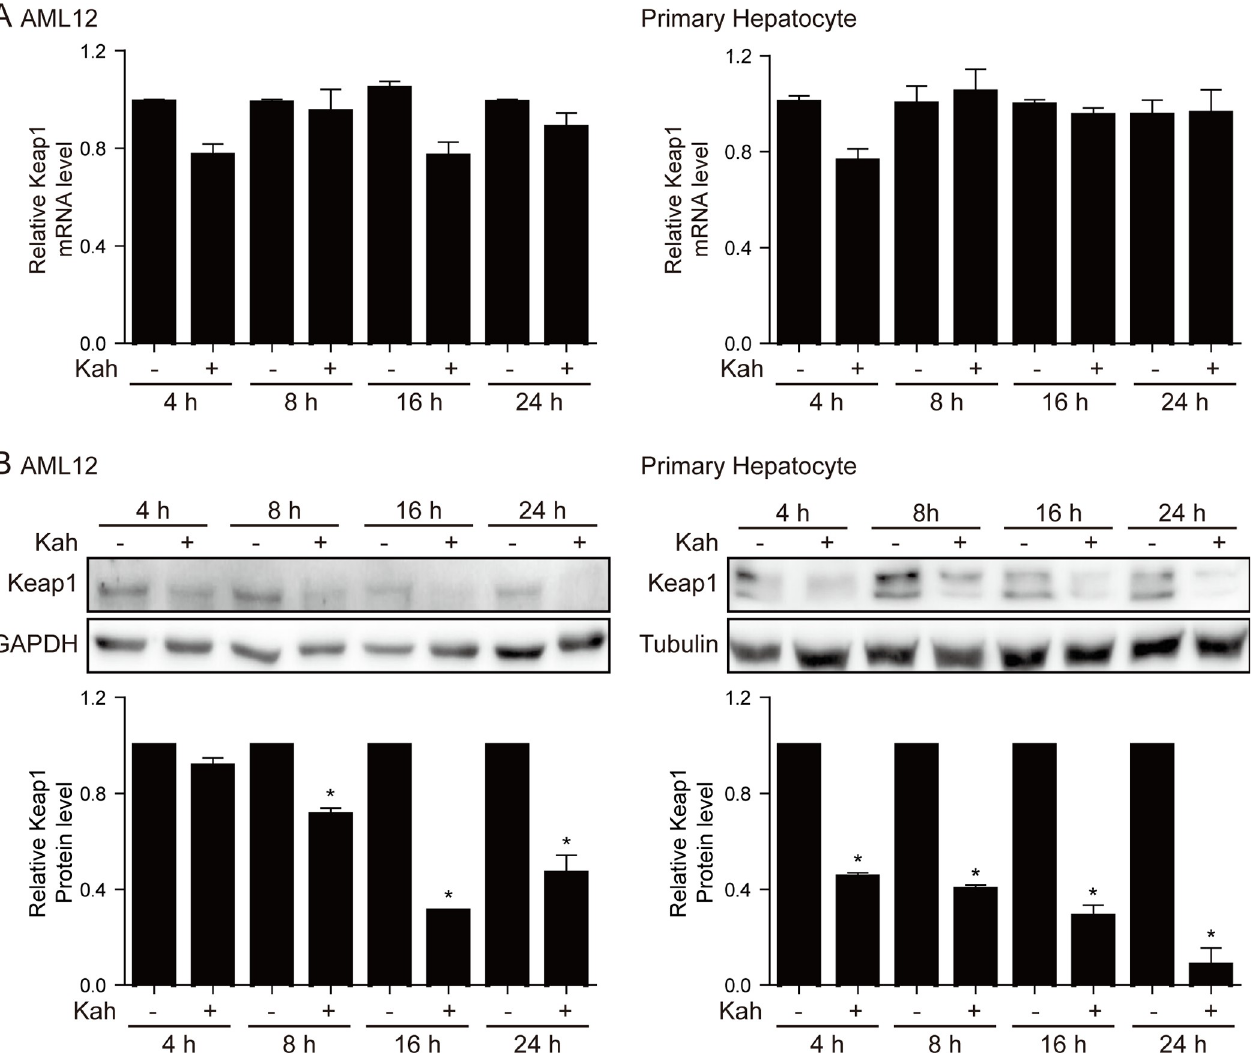
Fig 3. The effect of kahweol (Kah) on Keap1 expression. AML12 cells were treated with 20 μ M kahweol and primary hepatocytes were treated with 40 μ M kahweol. ( A, B ) Real-time RT-PCR ( A ) and western blot ( B ) analyses of Keap1 mRNA and protein levels, respectively, in AML12 cells (left) and primary hepatocytes (right). Data in the bar graphs are means ± SEM of three independent measurements. � p < 0.05 compared with the control for each time.